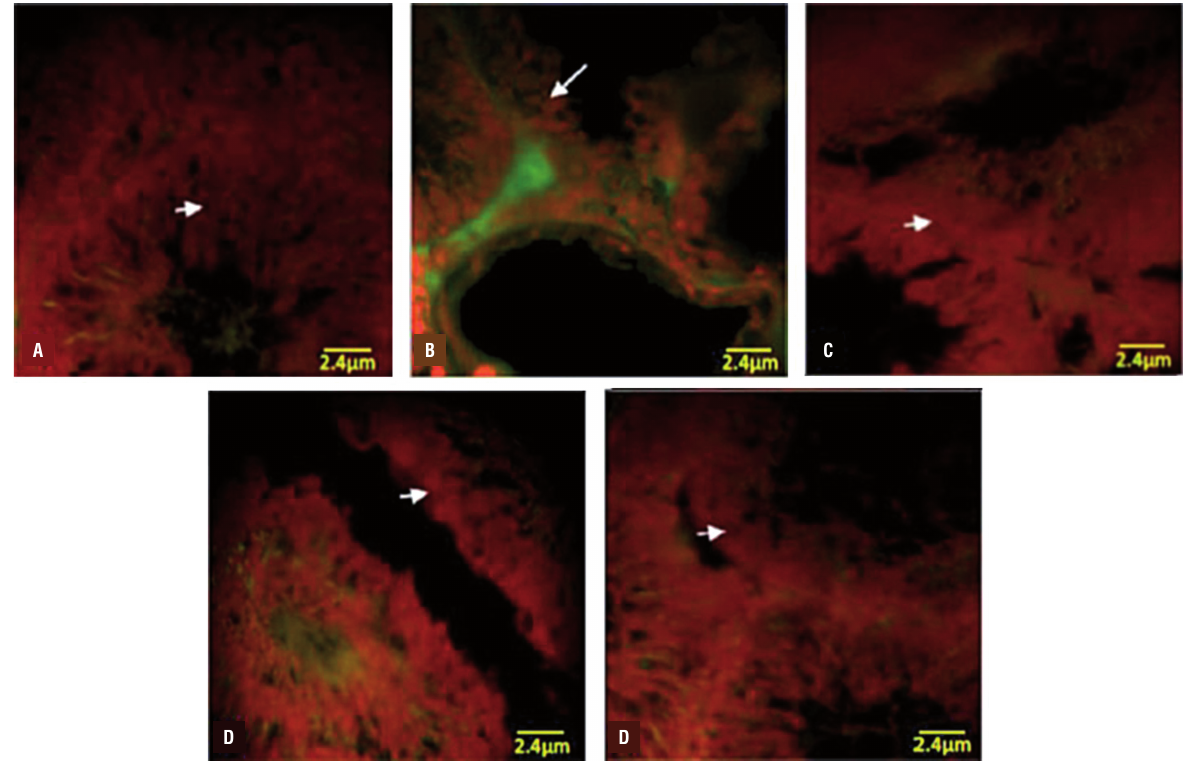
Figure 3 - Fluorescent photomicrograph of testes. (A) control-sham group: the germinal cells in different layers are presented with remarkably higher normal mRNA levels (arrow); (B) VCL induced group: severe RNA damage has been marked with faint yellowish red appearance (arrow); (C) VitE-treated; (D) testosterone-received; (E) VitE+testosterone-administrated groups; simultaneous administration of VitE and testosterone remarkably inhibited mRNA damage (arrows). Fluorescent staining for mRNA